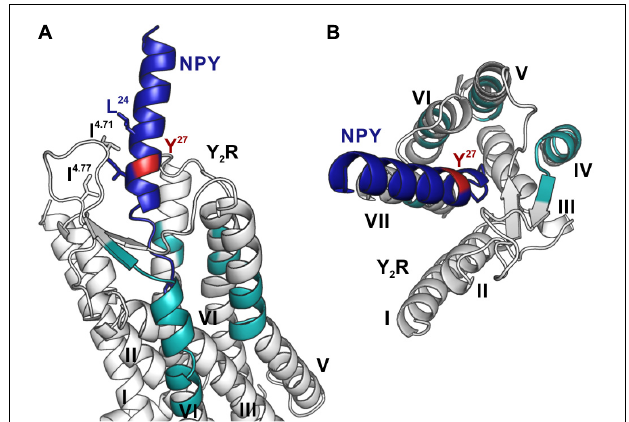
FIGURE 8 | Model of NPY bound to Y 2 R. Fragments, which were identified by photo-crosslinking studies in combination with MALDI-ToF MS and tandem MS/MS, between position 27 (red) of NPY (blue) and Y 2 R_cysteine_deficient (gray) are labeled in cyan. The model is based on the model by Kaiser et al. (2015). (A) Position 27 of NPY binds toward the top of TM 5, 6, 7 as well as to the top of TM 4 and ECL2, reflecting the flexibility of this position, which has no fixed interaction partner. (B) Top view of NPY binding to Y 2